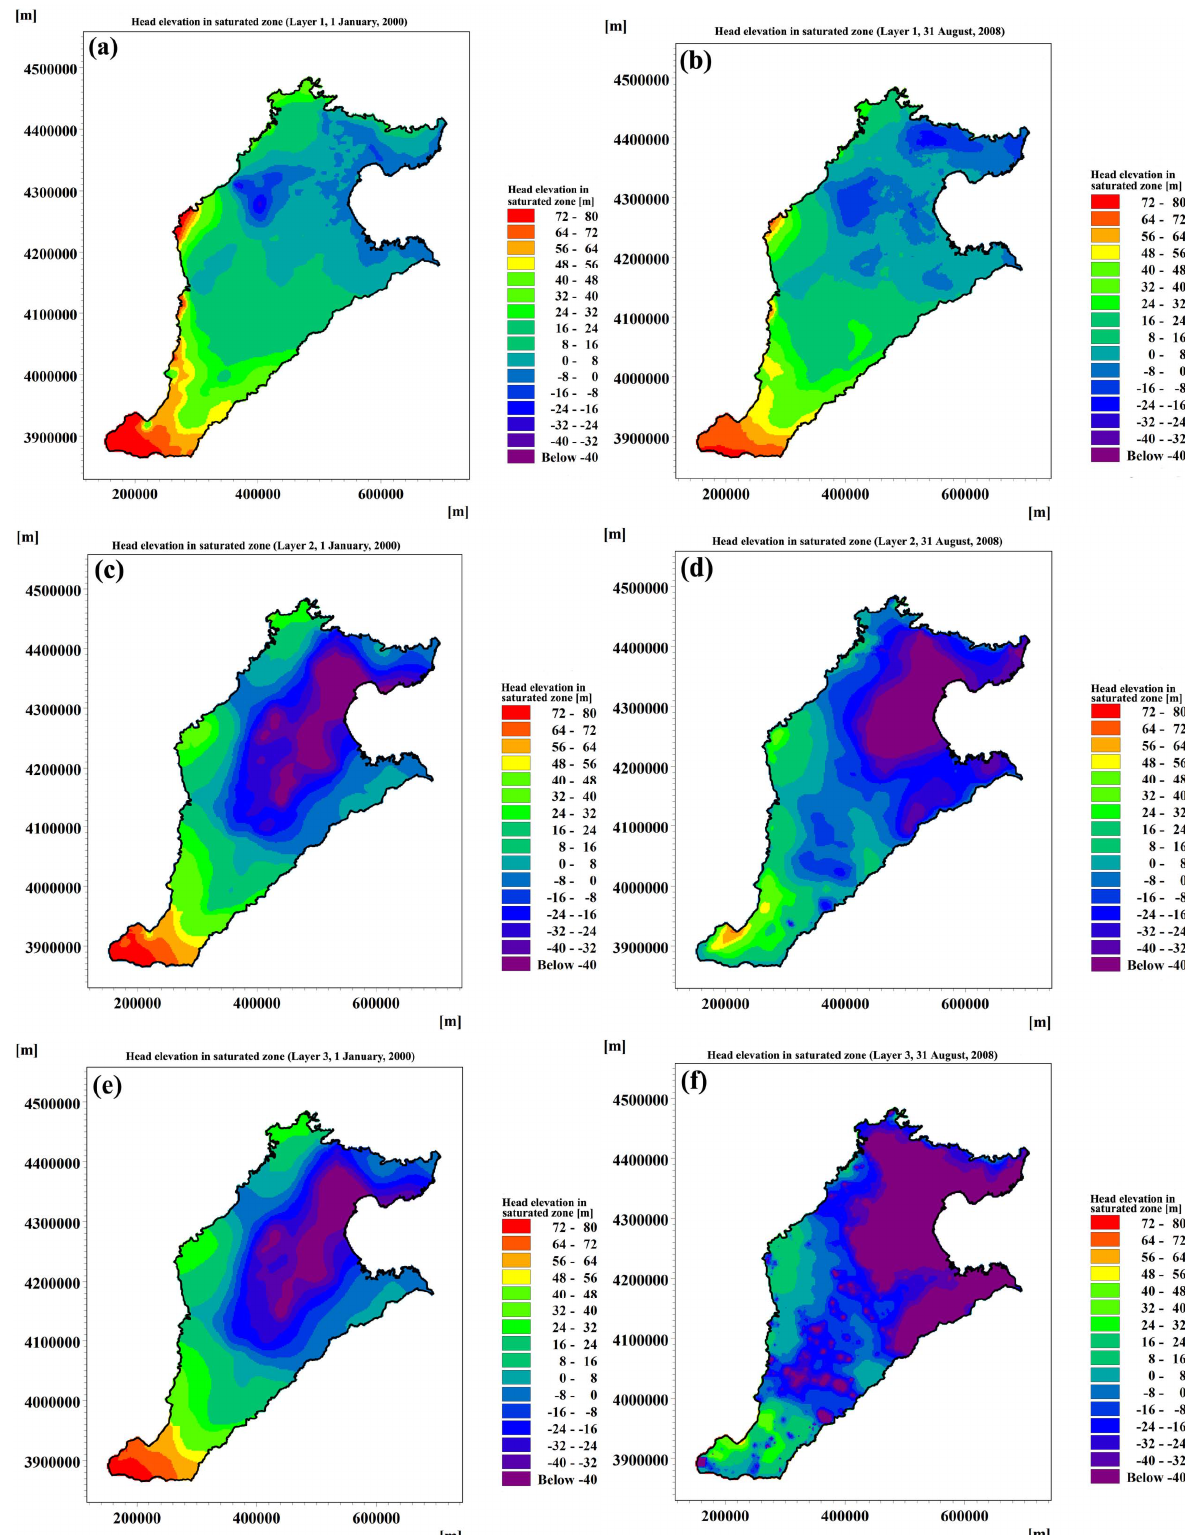
Fig. 13. Simulated groundwater head configurations on 1 January, 2000 and 31 August, 2008. (a) , (c) and (e) are head elevations on 1 January, 2000 for layer 1, 2, and 3, respectively; (b) , (d) and (f) are head elevations on 31 August, 2008 for layer 1, 2, and 3,